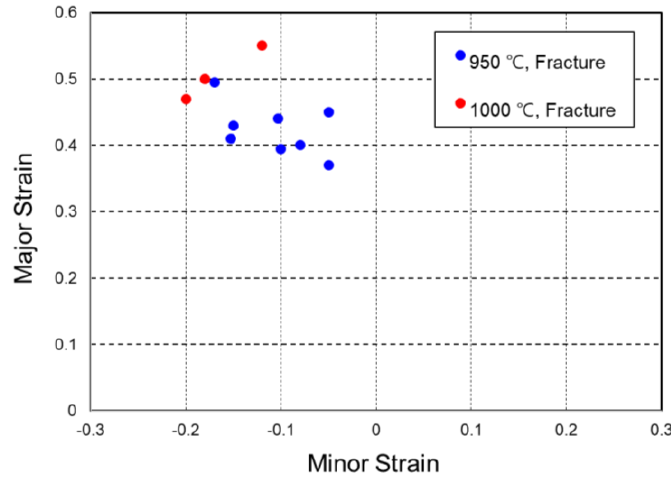
Figure 6. Major strain and minor strain at fracture according to heating temperature of sheet blank obtained from forming analysis corresponding to forming test of T-type part. Table 4. Values of process and material variables considered for evaluating the effect on formability.